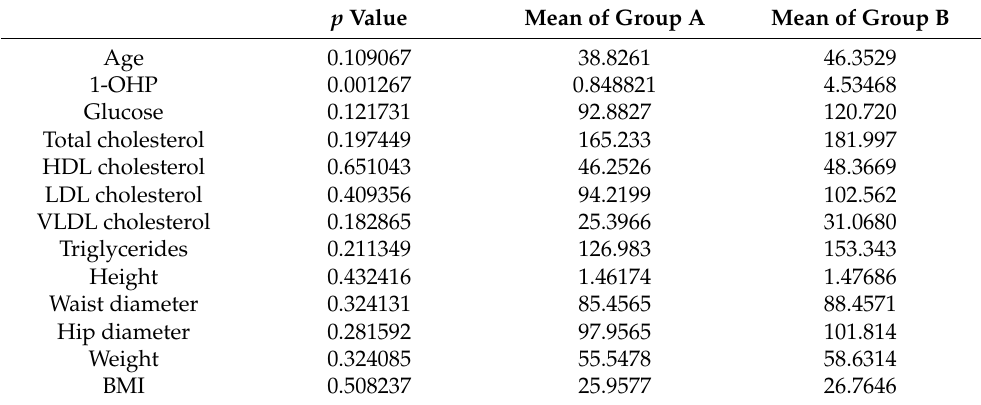
Table 2. Biochemical and anthropometric features analyzed by multiple t -tests of two-way ANOVA of urine samples exposed to PAHs.